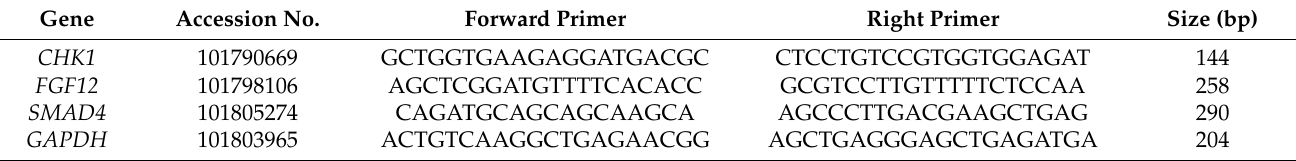
Table 1. Primers used for quantitative real-time